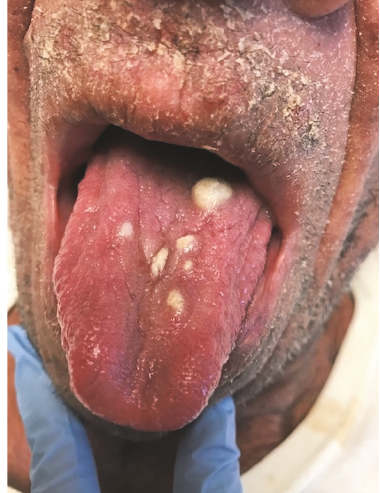
Figure 3: White nodules of the dorsal tongue.